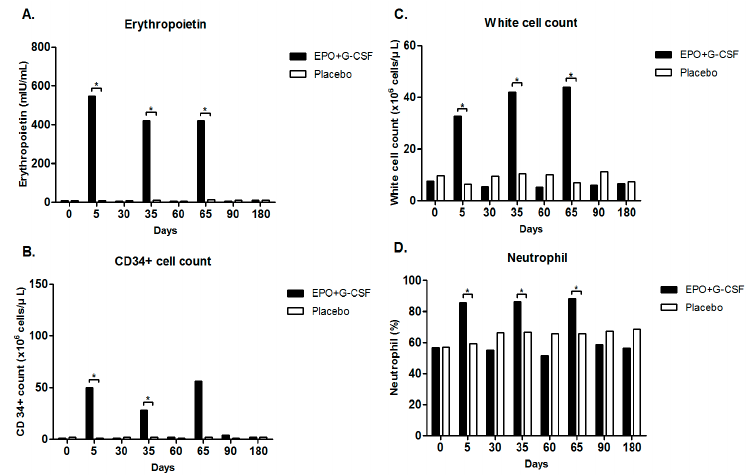
Figure 3. Laboratory measures for a total of 3 cycles in an exploratory double-blind study. ( A ) Erythropoietin concentration; ( B ) CD34 + cell; ( C ) white cell count; and ( D ) neutrophil on days 0, 5, and 30 of each cycle, and 6-month by EPO+G-CSF combination therapy or placebo control. EPO+G-CSF group showed significant peaks on four parameters on day 5 compared with placebo control in each cycle. The hematological patterns repeated every three cycles and returned to baseline values in participants who completed 3 cycles of intervention. Values are median. * p < 0.05 by Mann-Whitney U test.